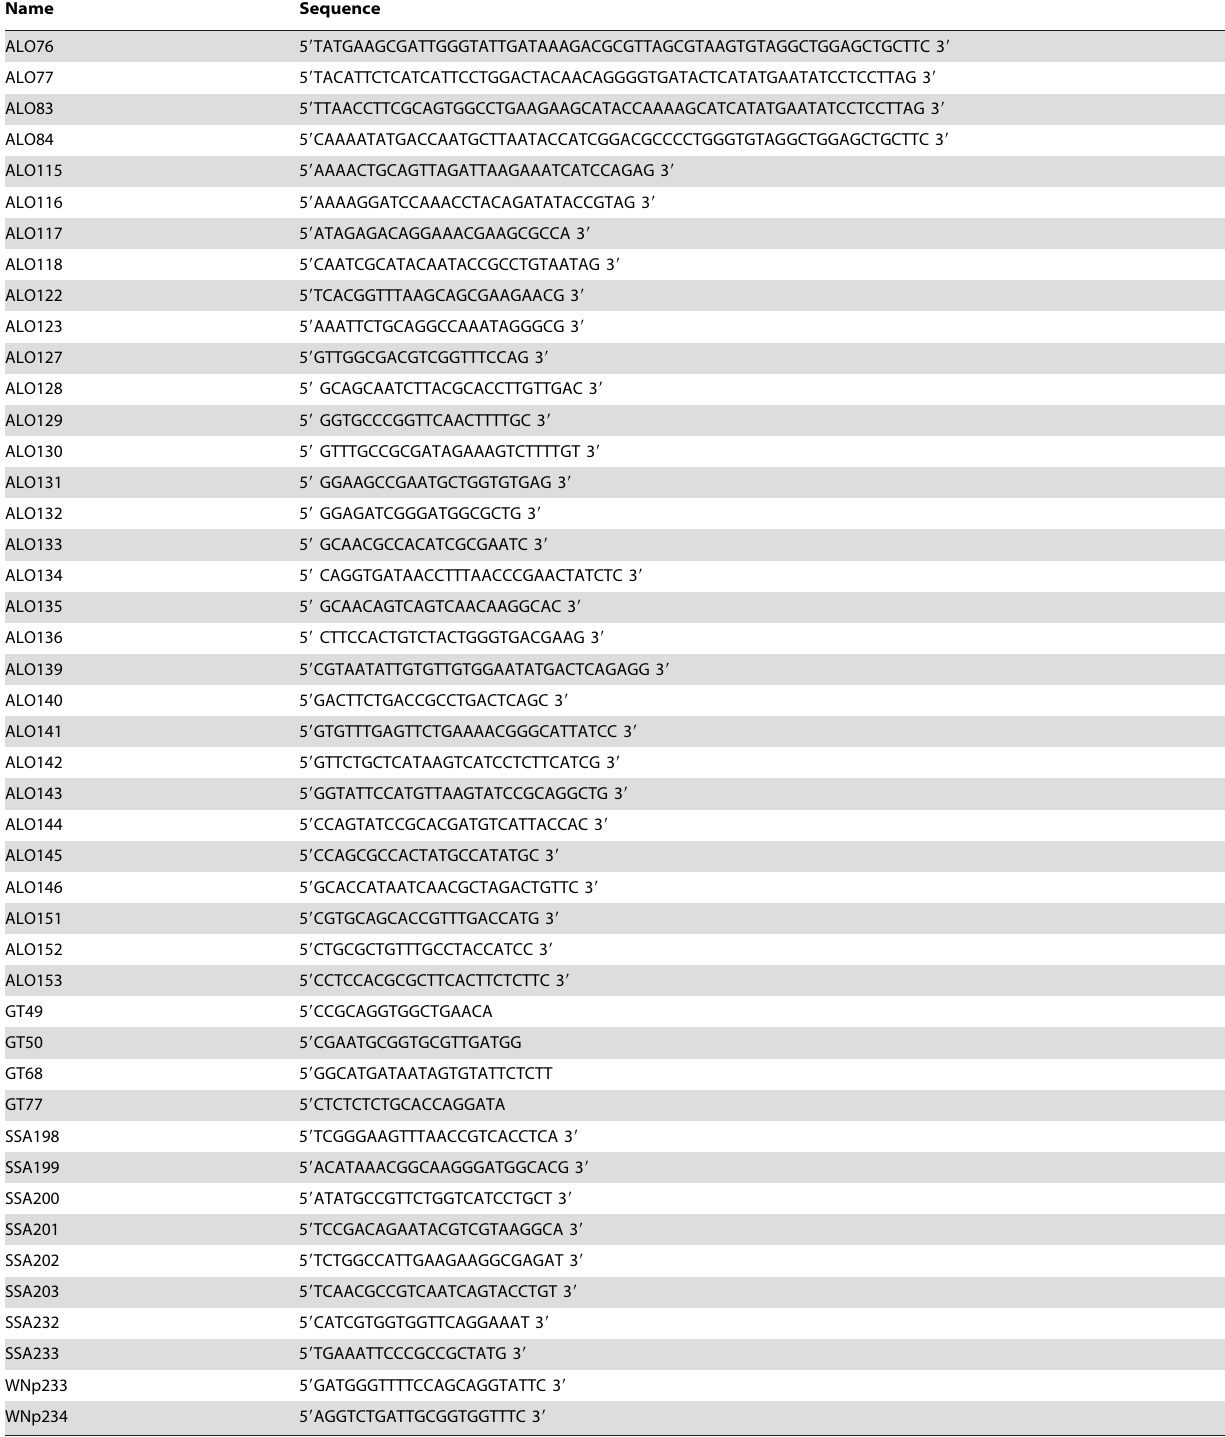
Table 5. Oligonucleotides used in this